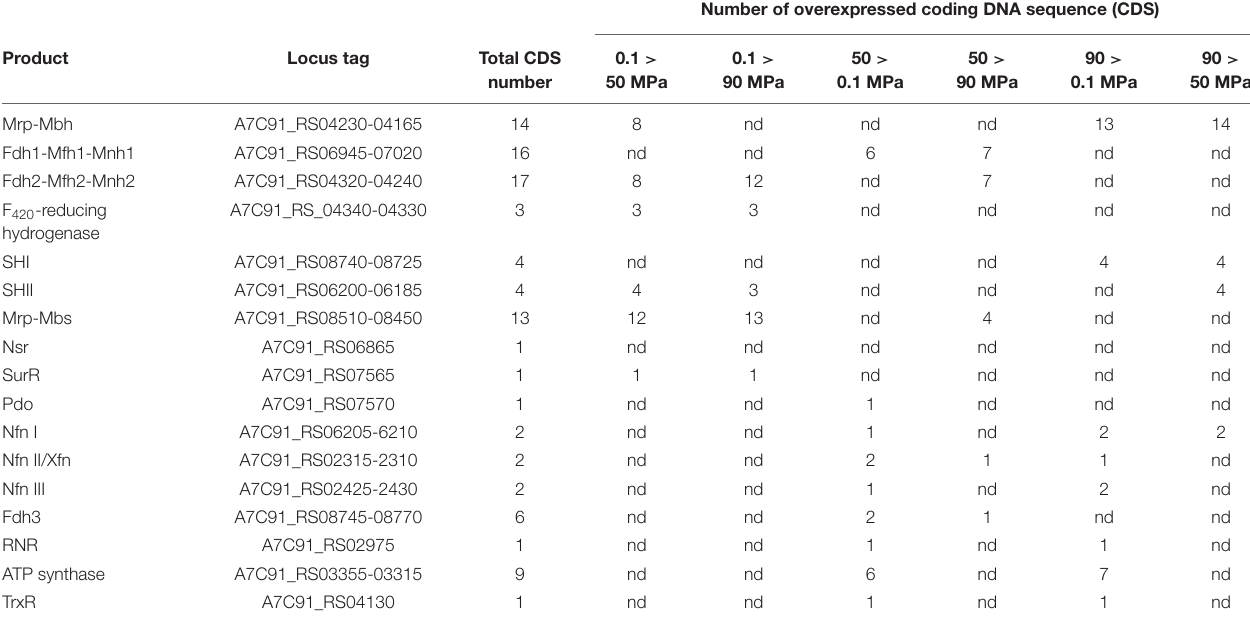
Number of overexpressed coding DNA sequence